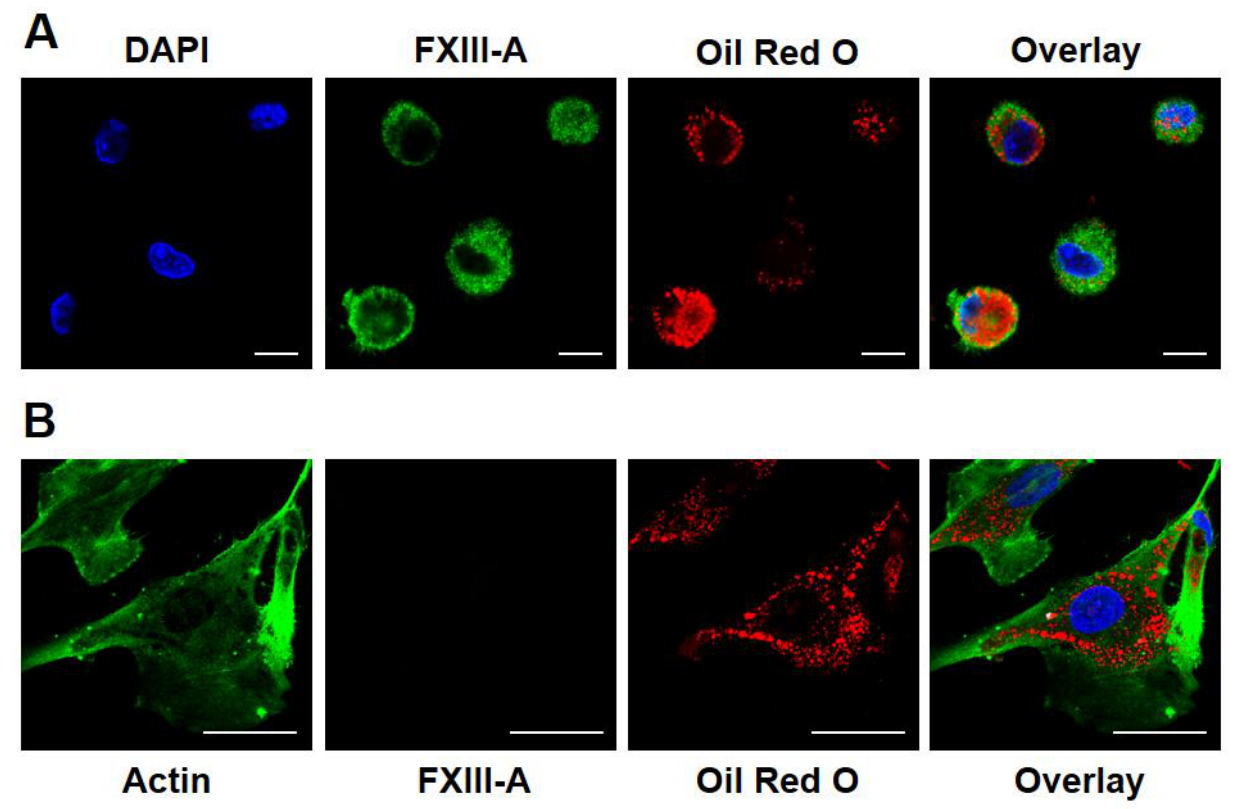
Figure 1. Investigation of FXIII-A expression in foam cells of different origin. ( A ) FXIII-A in macrophages transformed into foam cells by oxidized LDL ingestion. FXIII-A appears in green, while oxidized LDL is shown in red color. Scale bars correspond to 10 μm. ( B ) The lack of FXIII-A in vascular smooth muscle cells transformed into foam cells by ingestion of enzyme-modified non-oxidized LDL. Smooth muscle actin is depicted in green, while modified LDL is represented by red color. Scale bars correspond to 50 μm.